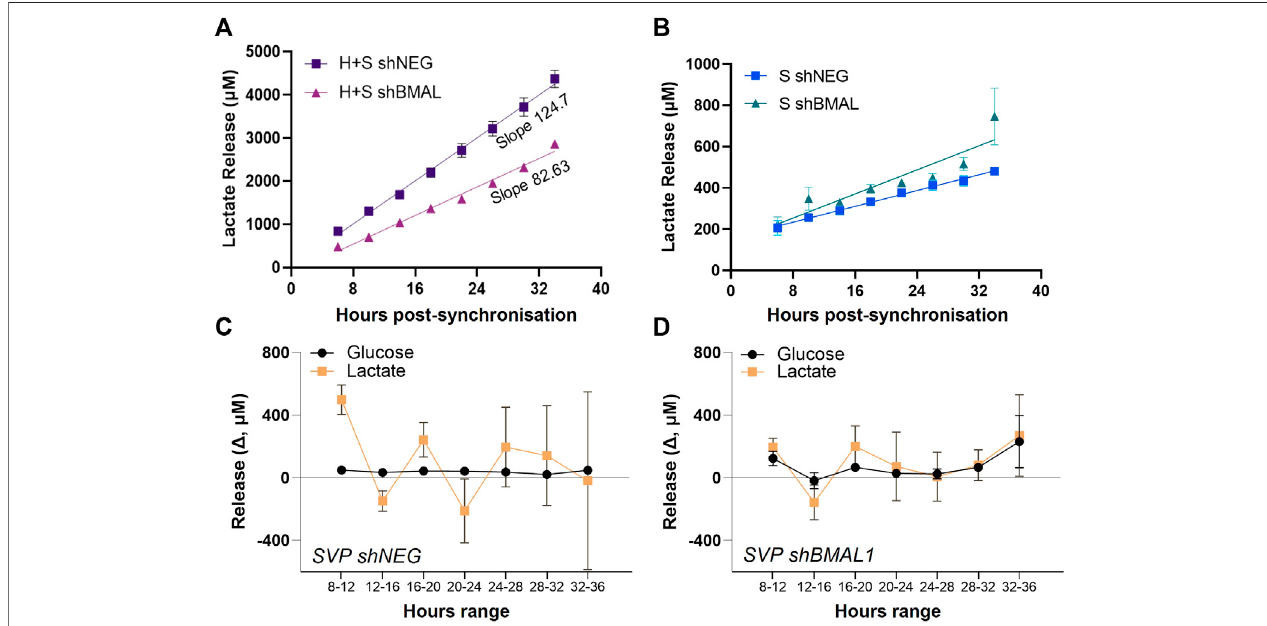
FIGURE 4 | Pericytes ’ clock in fl uences endothelial cells ’ lactate release. Lactate accumulation in the supernatants of saphenous vein pericytes (SVP, S), transduced with control lentivirus (shNEG) or shBMAL1, and either co-cultured with wild-type human umbilical endothelial cells (HUVEC, H) (A) or cultured alone (B) . Linearregressionisover-imposed.Incrementalchange( Δ )inlactateandglucoseconcentrationinthesupernatantsofSVPshNEG (C) andSVPshBMAL1 (D) ,relativeto previous